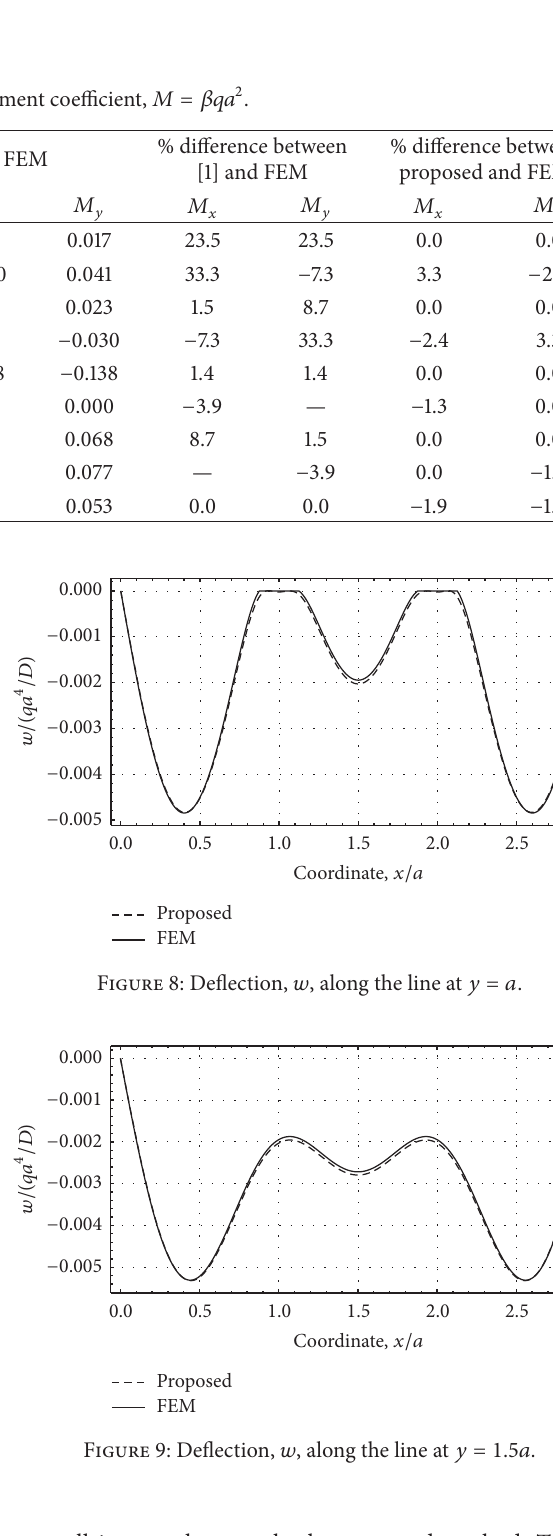
one cell is enough to apply the proposed method. Table